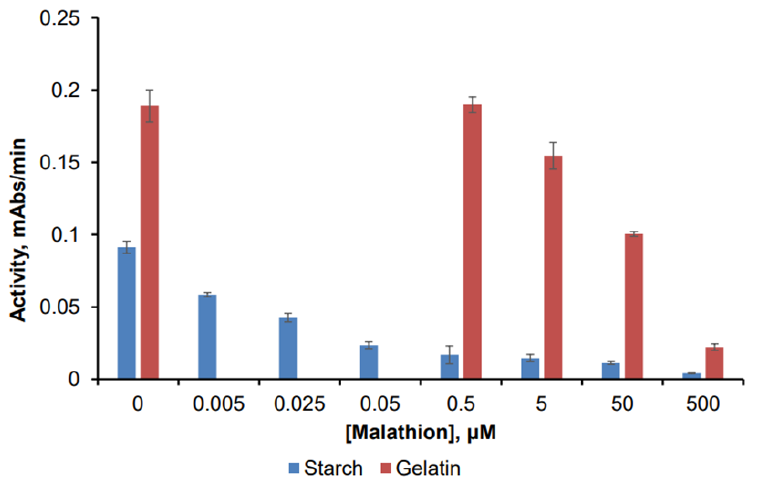
Figure 5. The rate of enzymatic hydrolysis of S-BCh-I as dependent on the type of the carrier used for co-immobilization of BChE and DTNB in the presence of malathion. Each preparation disk con- tained 0.11 U of BChE and 0.2 mM DTNB. 0.11 U of BChE and 0.2 mM